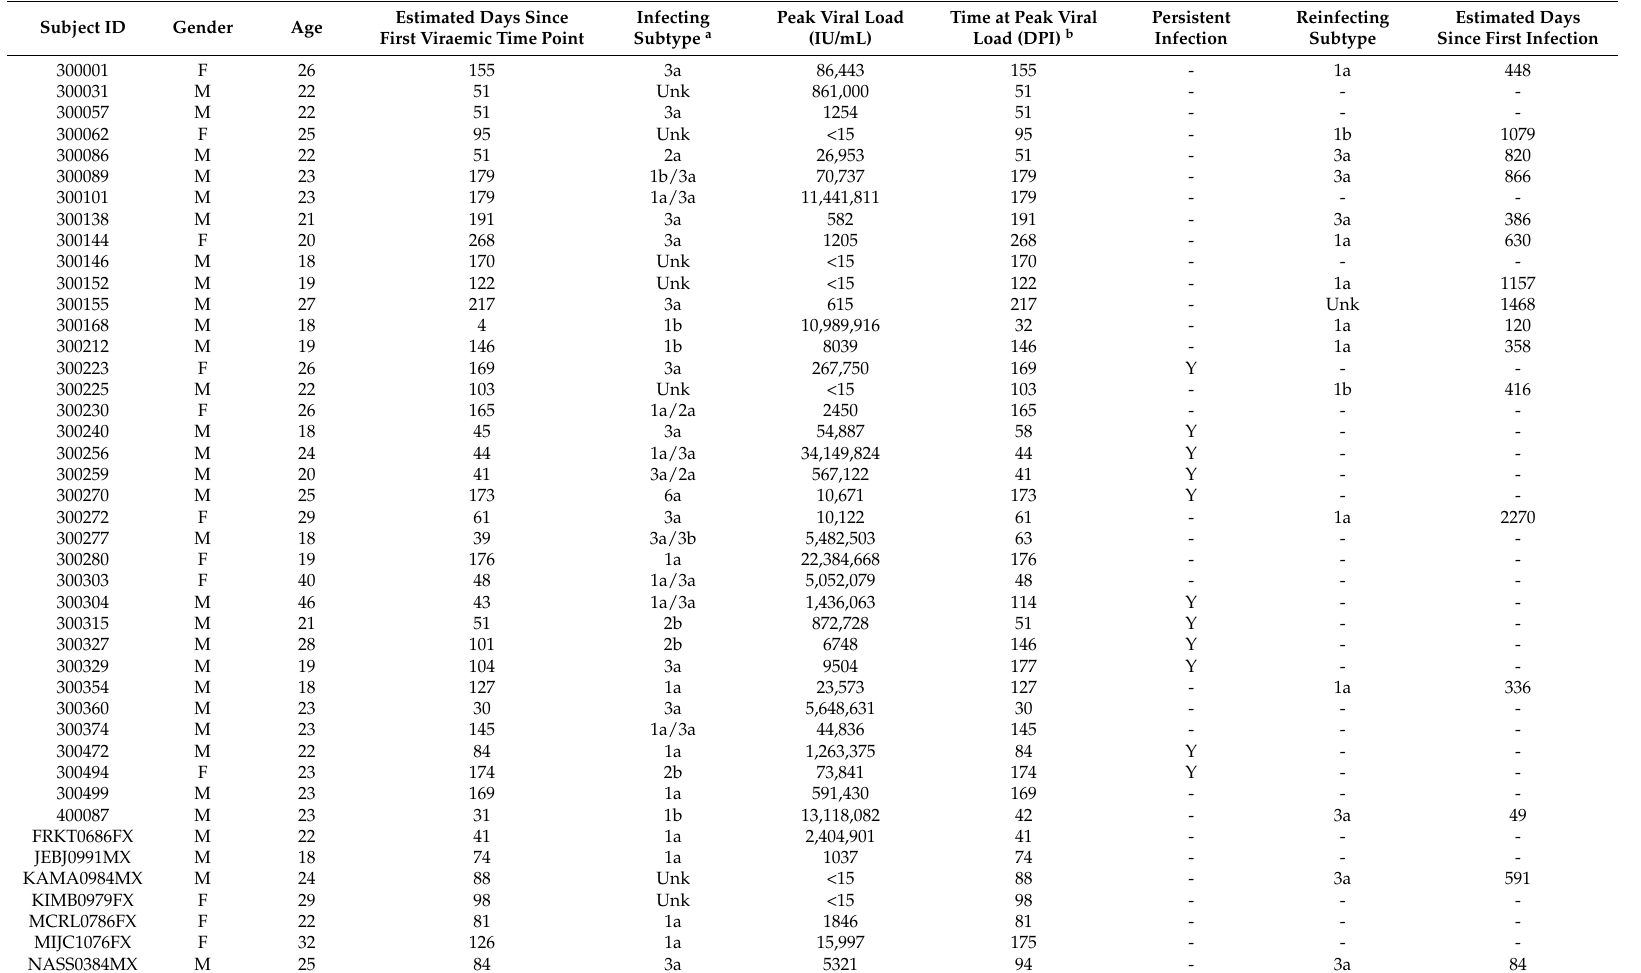
Table 1. Patient data